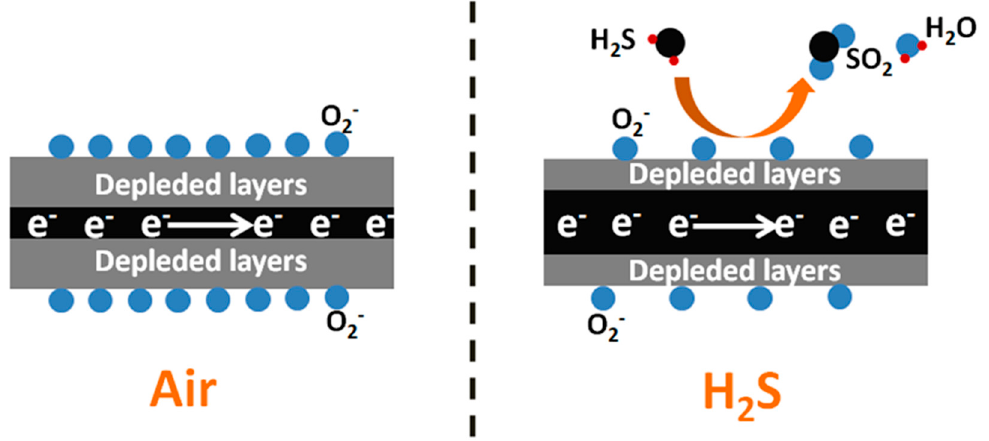
Figure 5. The schematic diagram of the gas-sensing reaction process.